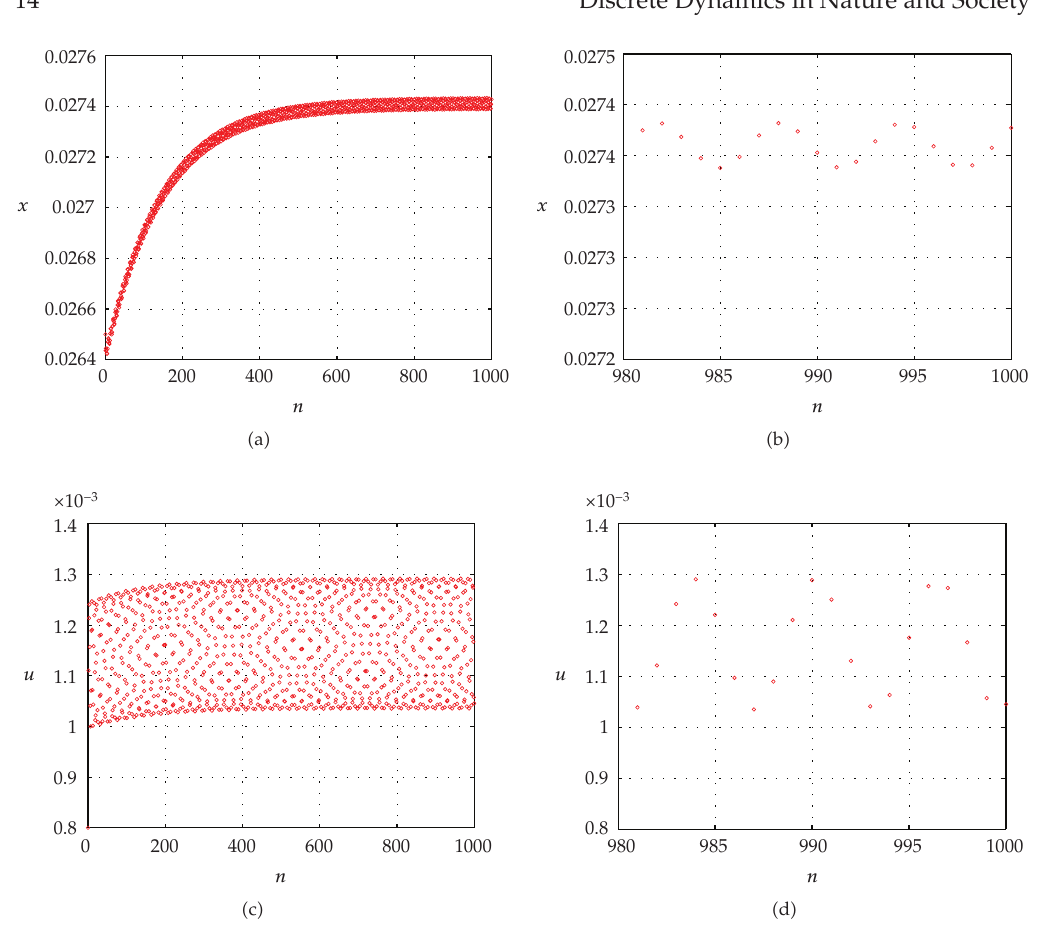
Figure 1: Permanence of system (cid:5) 4.1 (cid:6) with x (cid:5) − 1 (cid:6) (cid:7) 0 . 04 and { x (cid:5) 0 (cid:6) ,u (cid:5) 0 (cid:6) } (cid:7) { 0 . 0265 , 0 . 0008 } . (cid:5) a (cid:6) and (cid:5) b (cid:6) show x for k ∈ (cid:3) 0 , 1000 (cid:4) and x for k ∈ (cid:3) 980 , 1000 (cid:4) , respectively. (cid:5) c (cid:6) and (cid:5) d (cid:6) show u for k ∈ (cid:3) 0 , 1000 (cid:4) and u for k ∈ (cid:3) 980 , 1000 (cid:4) ,